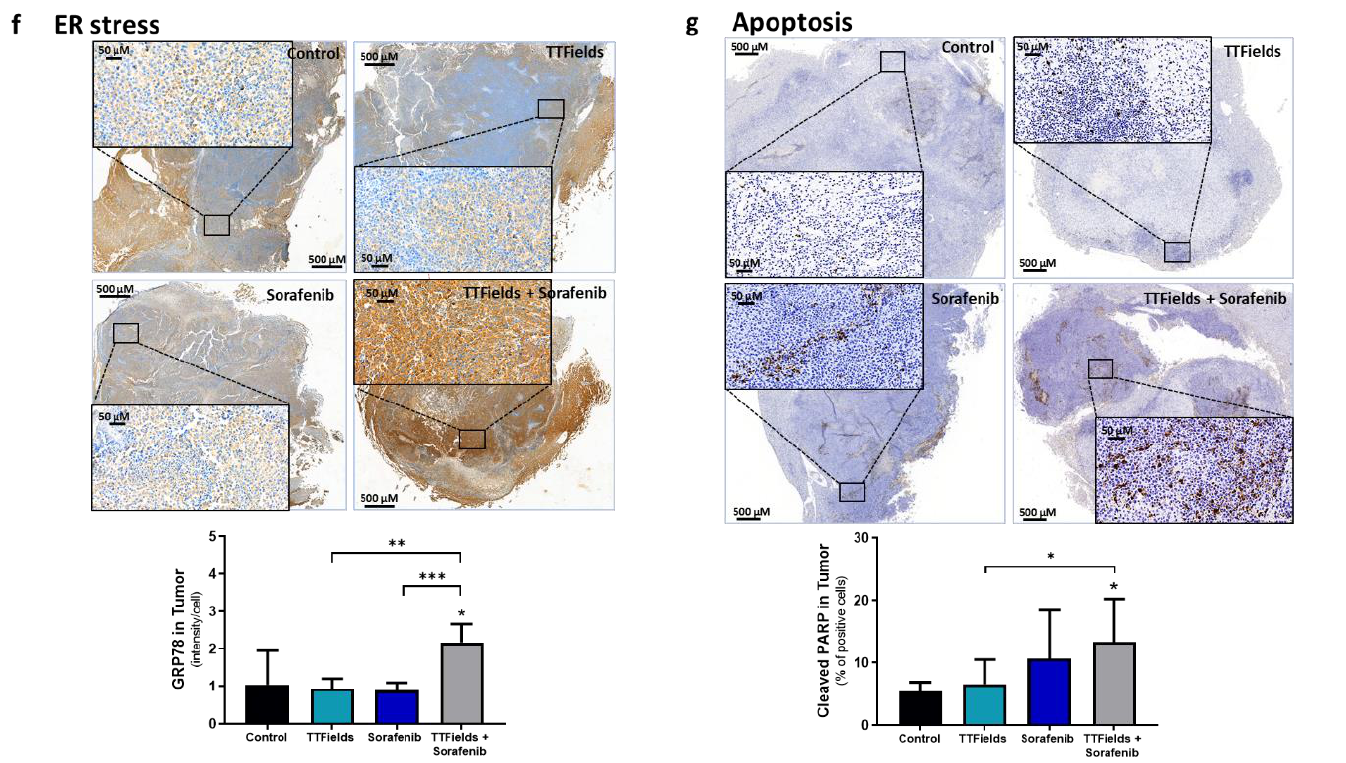
Figure 4. In vivo efficacy of TTFields in combination with sorafenib. Rats ( n = 52) were inoculated orthotopically with rat HCC N1S1 cells, and treated with sham-vehicle ( n = 11), TTFields alone ( n = 15), sorafenib alone ( n = 10), or TTFields + sorafenib ( n = 16), according to the depicted timeline ( a ). MRI images were captured at the start and end of the study (( b ), representative images), from which tumor volume fold change was calculated ( c ). At study end, tumors were removed and weighed ( d ), and tumor slices were subjected to immunohistochemical analysis for beclin-1 and LC3 ( e ), GRP78 ( f ), and cleaved PARP ( g ). Values are mean ± SD. * p < 0.05, ** p < 0.01, *** p < 0.001, and **** p < 0.0001 relative to control for labels above bars, or between indicated groups; Student’s T-test. HCC = hepatocellular carcinoma; MRI = magnetic resonance imaging; SD = standard deviation; TTFields = Tumor Treating